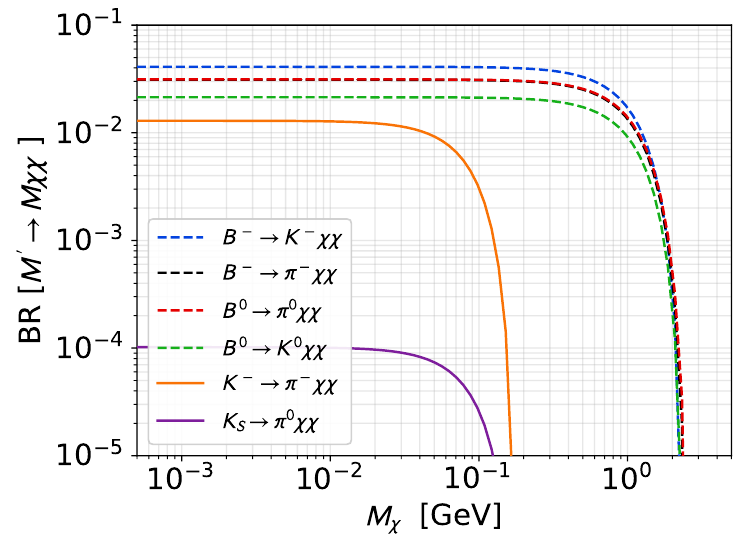
Figure 2 . Branching ratios as function of the light dark sector mass for B and K heavy mesons, with M 1 = M 2 = M (cid:31) . We have set the relevant couplings g ij = 1 and the e(cid:11)ective scale (cid:3) = 1